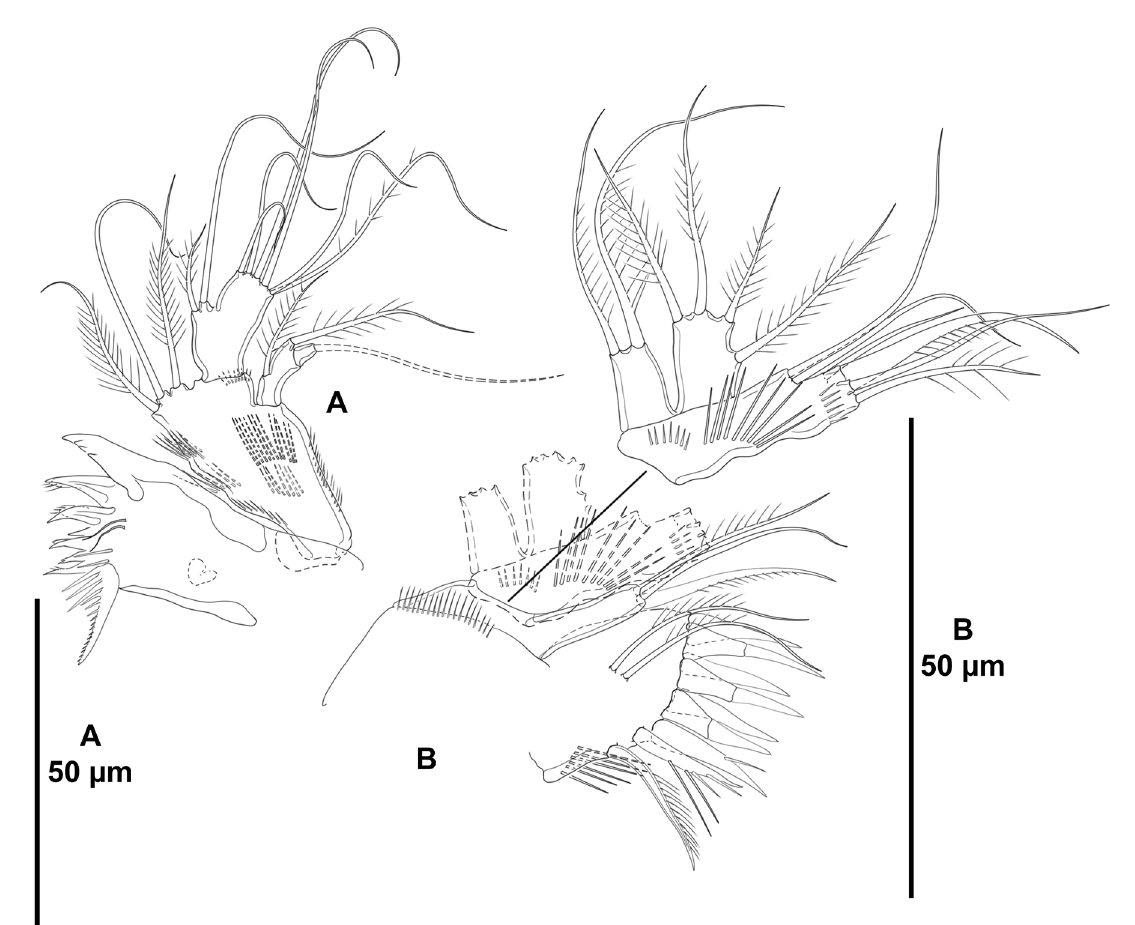
Fig. 4. Typhlamphiascus medici sp. nov., paratype, ♀ (ICML-EMUCOP-180119-41). A . Mandible. B .